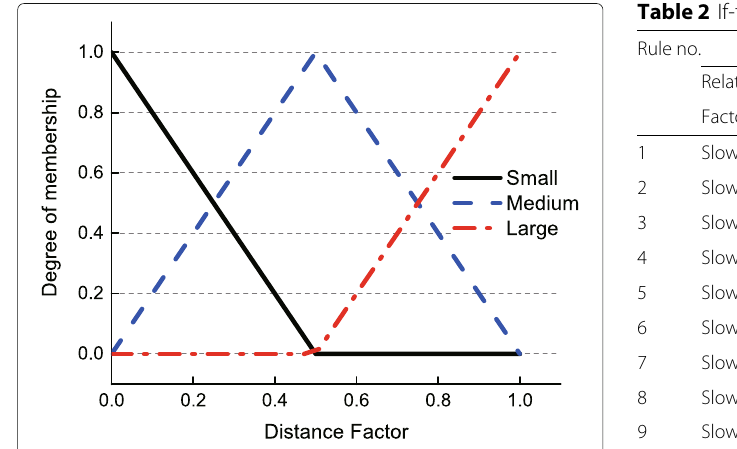
Fig. 9 Membership function of the distance